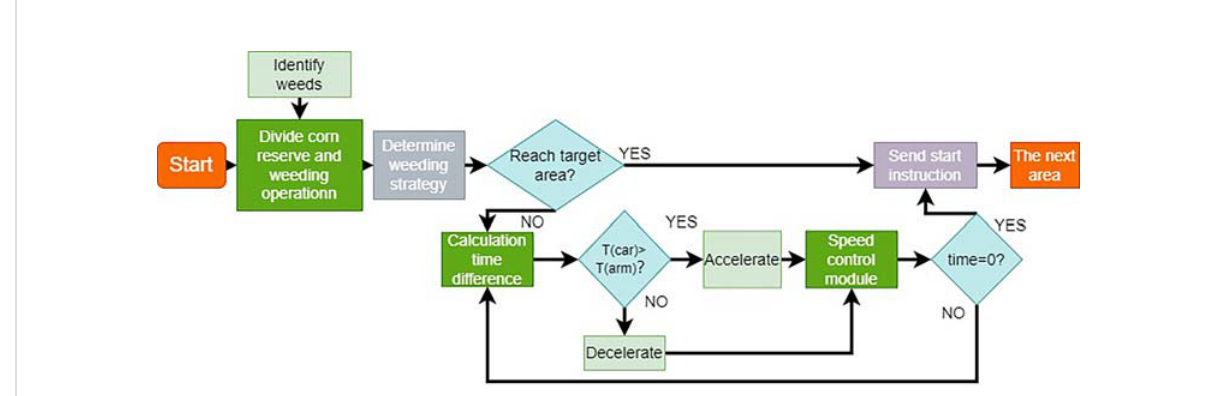
FIGURE 9 Flow chart of weeding process 1. laser emitter 2. robot arm I 3. robot arm II 4. robot arm III 5. robot arm IV 6. robot arm turntable 7. servo motor.